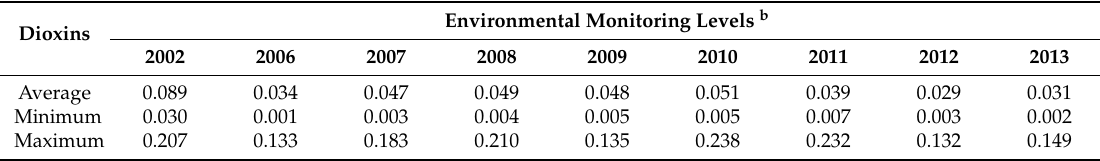
Table 3. Environmental monitoring levels for dioxins during the years of 2002–2013 in Taiwan a .